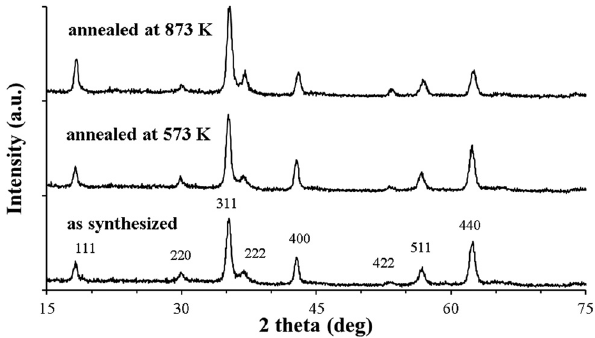
Figure 1: X - ray diffraction patterns of thin film samples measured at a fixed incidence angle of